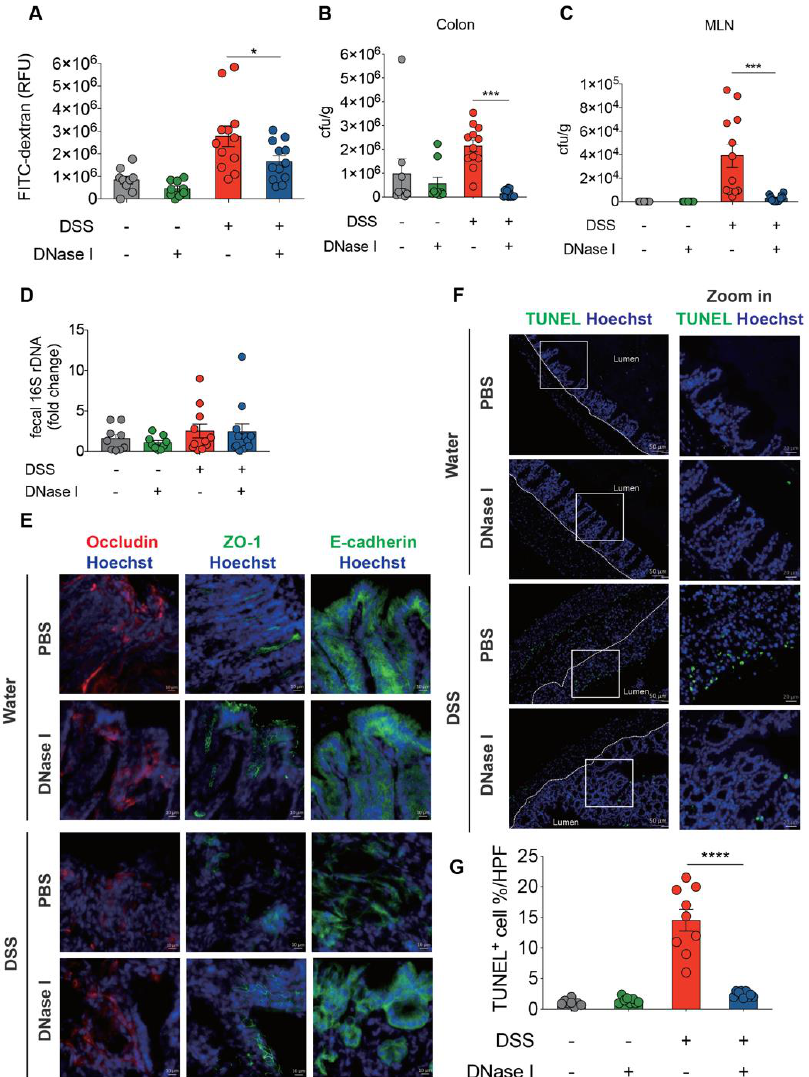
Figure 5. NETs alter intestinal barrier function and cause the apoptosis of intestinal cells in the colon of DSS-treated mice. ( A ) Intestinal permeability was determined by quantifying the amount of fluorescein isothiocyanate (FITC)-dextran levels in the serum 4 h after its oral gavage. PBS- or DNase I-administered wild-type C57BL/6 mice fed clean water or 2.5% DSS were tested on day 8 from the beginning of the DSS treatment. ( B , C ) Bacterial counts in the colon and mesenteric lymph nodes (MLN) of control or DSS mice treated with PBS or DNase I were determined on day 8. ( D ) Quantitative PCR analysis of relative amount of 16S rDNA in the feces of control and DSS mice treated with PBS or DNase I on day 8. (A-D) The results are pooled data from two separate experiments. n = 9 mice per control groups and n = 12 mice per DSS groups. ( E , F ) Representative immunofluorescence staining of occludin, ZO-1, E-Cadherin, and Hoechst 33342-stained DNA and representative fluorescent images of terminal deoxynucleotidyl transferase dUTP nick-end labeling (TUNEL, green) staining of the colon tissues isolated from PBS- or DNase I-administered wild-type C57BL/6 mice on day 8 after the consumption of clean water or 2.5% DSS. Slides were counterstained with Hoechst 33,342 (blue). ( G ) Percentage of apoptotic cells per 200X high-power field (HPF) in each group listed in f. The results are pooled data from two separate experiments. n = 8 mice per control groups and n = 9 mice per DSS groups. The data represent the mean ± SEM. Statistical analyses were performed using A-D, G one-way ANOVA with Turkey’s multiple comparison or E, unpaired two-tailed t -test. * p < 0.05, *** p < 0.001, **** p < 0.0001. Scale bar, 10 µm in E; 50 µm in the left panel and 20 µm in the zoom of F.